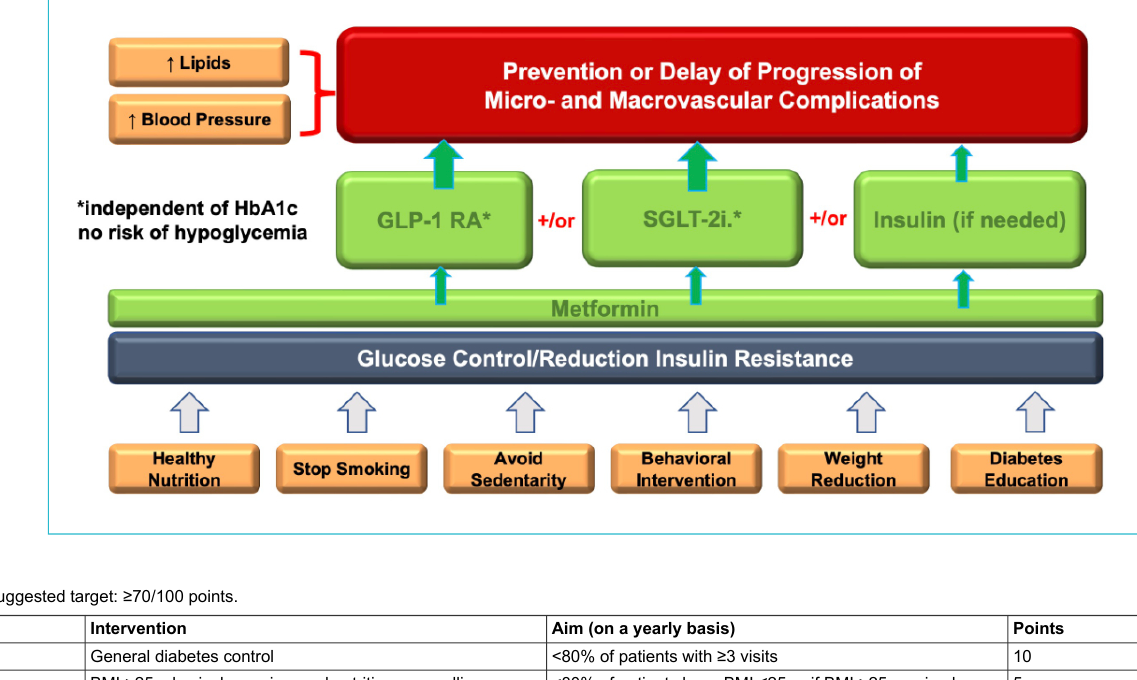
Figure 3: Important factors in diabetes treatment.